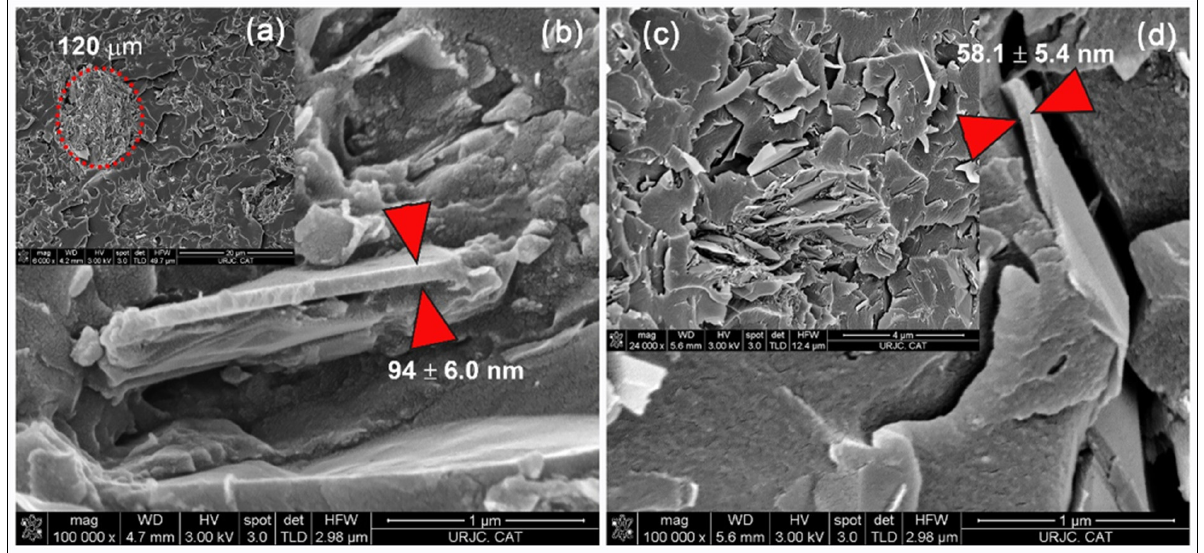
Figure 6. FEG-SEM images of GNP/epoxy composite reinforced with C300 ( a , b ) and C750 ( c , d ).